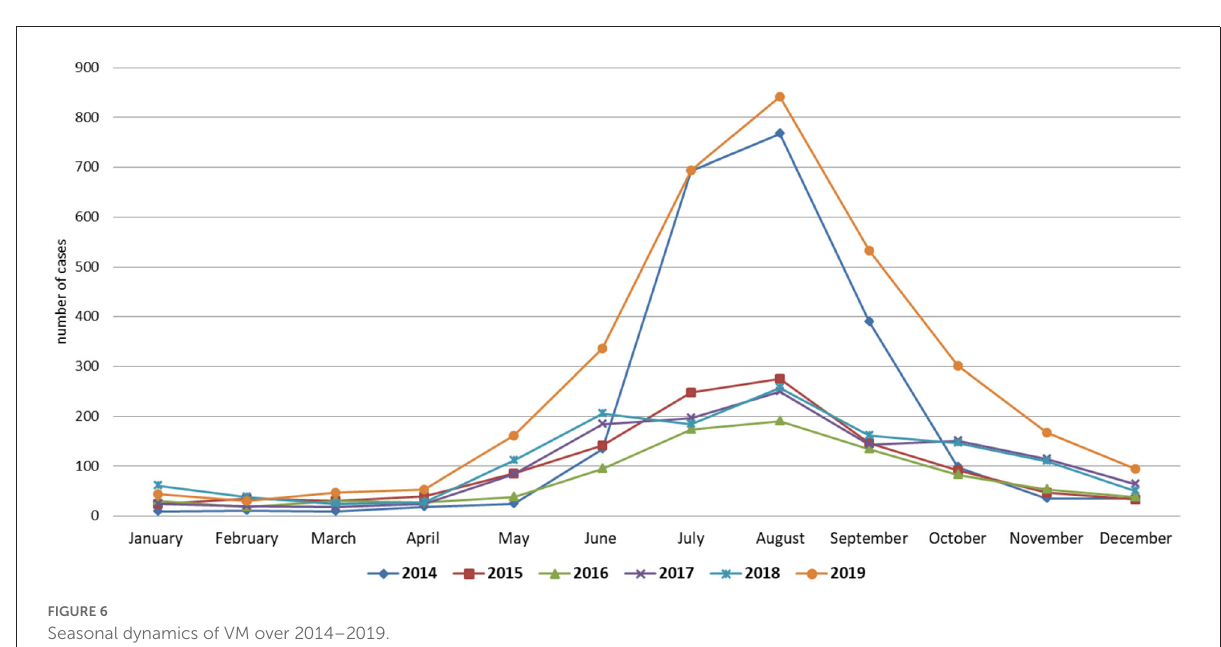
FIGURE6 Seasonal dynamics of VM over 2014–2019.